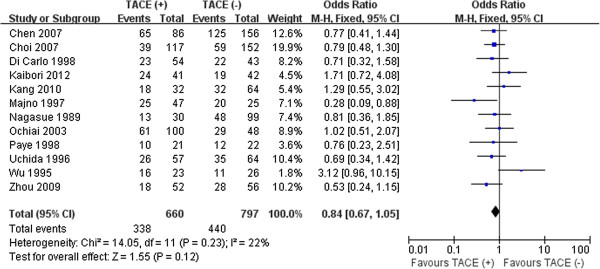
Results of the meta-analysis on intrahepatic recurrence.